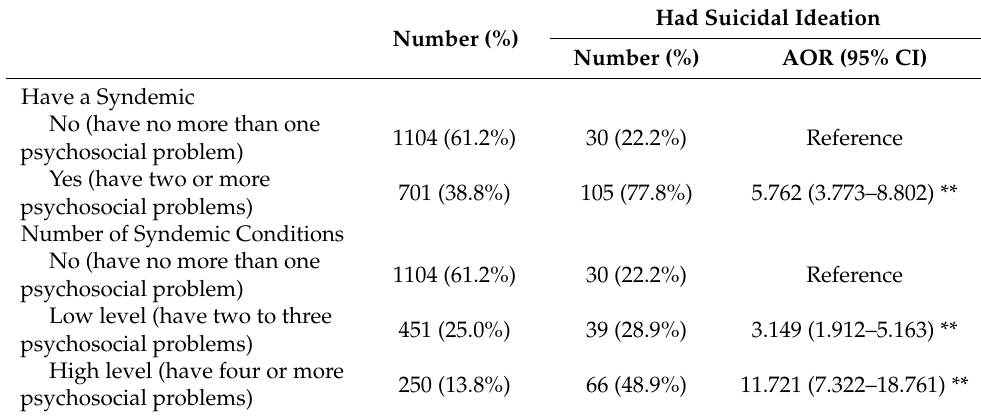
Table 4. The association between the number of syndemic conditions and suicidal